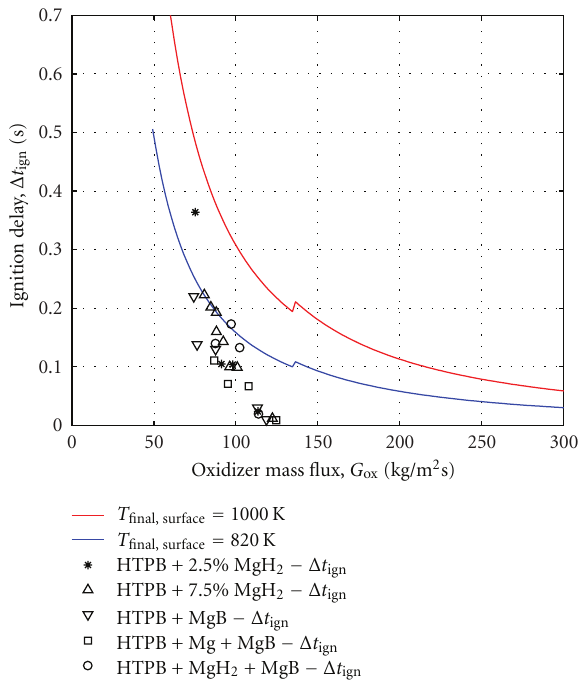
Figure 12: Ignition delay for magnesium-containing formulations. Comparison with the purely convective model by Ohlemiller and Summerfield [19], for two di ff erent final surface temperatures [25,